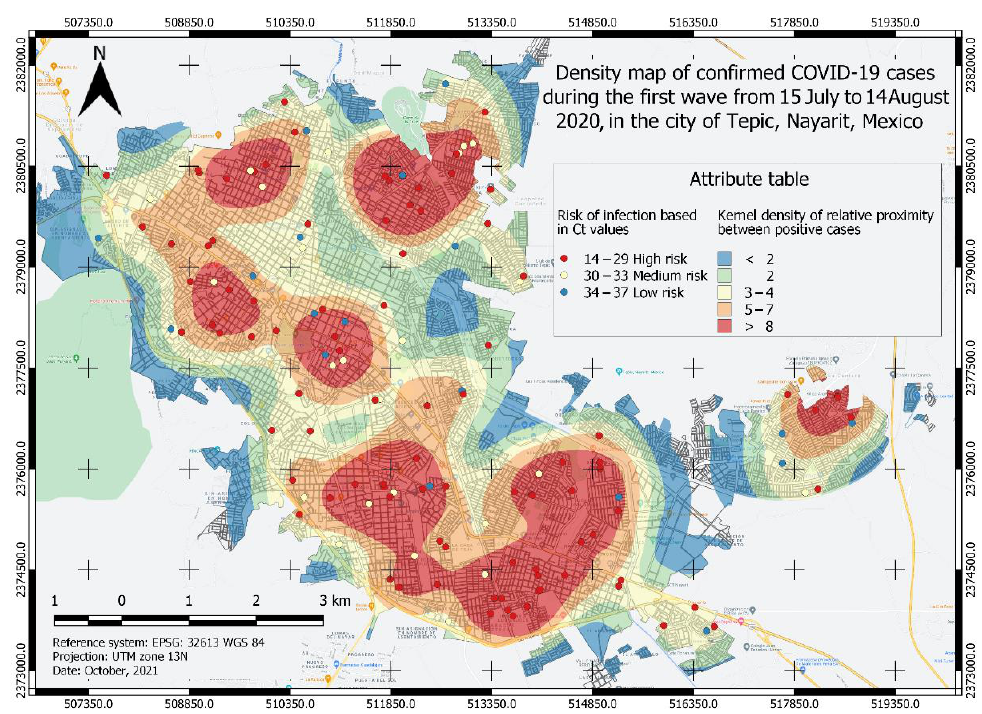
Figure 2. Density map of confirmed COVID-19 cases in the first wave from 15 July to 14 August 2020, in the city of Tepic, Nayarit, Mexico. The different areas classified by color indicate the level of risk of probability of contagion of the COVID-19 disease and each point corresponds to a confirmed case categorized by its Ct value.